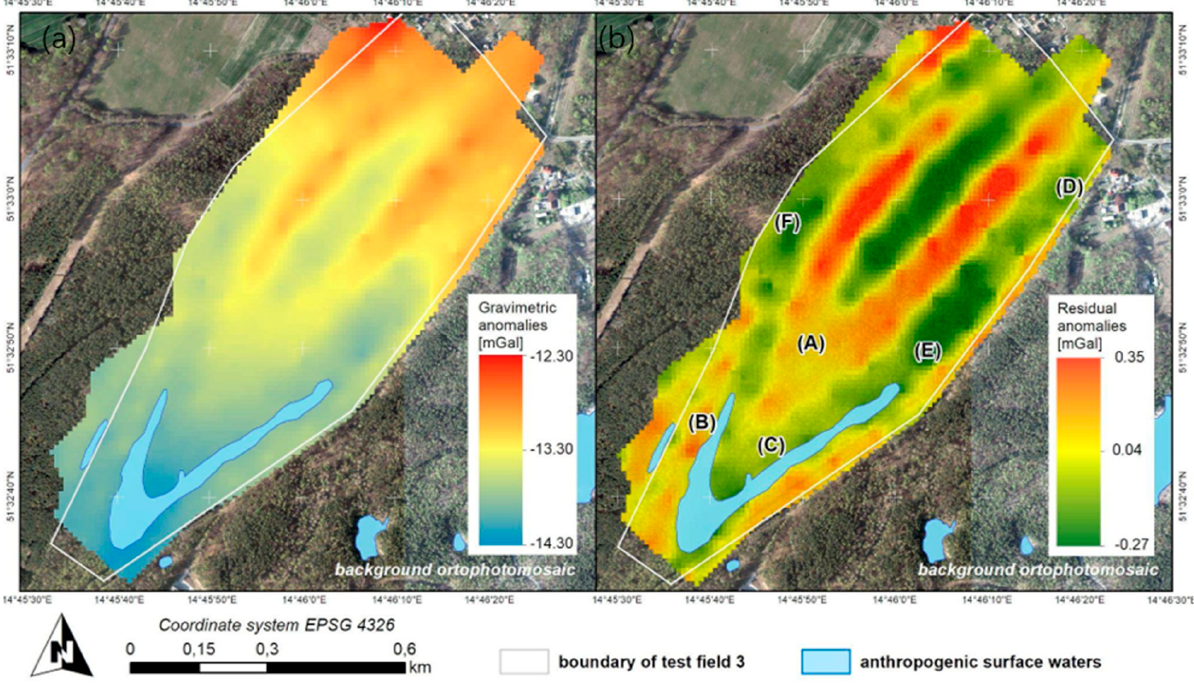
Figure 7. Gravimetric map: ( a ) Gravimetric anomalies in the Bouguer reduction; ( b ) Residual anomalies. The image of residual anomalies is dominated by alternating positive and nega- tive anomalous forms running from the central part of the area towards the north-east (Figure 7b). The two larger forms in the central part merge into one anomaly towards the SW (A). The anomaly near the NE border has three maxima, the largest of which reaches 0.28 mGal. In the southern part, near the anthropogenic lake (B), there are several small positive anomalies with values that do not exceed 0.15 mGal. There are three negative bands between the positive bands with a minimum value of − 0.27 mGal (C). The sequences of positive values (in the central and north-eastern part) are contoured by distinct densities separating the areas of positive and negative anomalies. This is probably related to the difference in density between the heavier Miocene formations and lighter anthropogenic formations and brown coal outcrops. In the central and southern parts of test field three, the density contrast is slightly lower, and may indicate transformation of the original environ- ment as a result of the brown coal mining and appearance of anthropogenic deposits (sand, gravel, peat, or silt). With respect to the particular test sites, the one located in the NE part of test field three is covered by a relatively negative residual anomaly, with a minimum of − 0.055 mGal (D), located near the south-eastern border of the site. The positive anomalous forms are visible mainly at the edges, and partially in the central part, of this area. This pattern of anomalies is related to the post-mining character of the test site, i.e., the presence of depressions filled with anthropogenic formations of lower density than the Table 1. Lithological and physic-mechanical classification of resistance complexes in the study area.